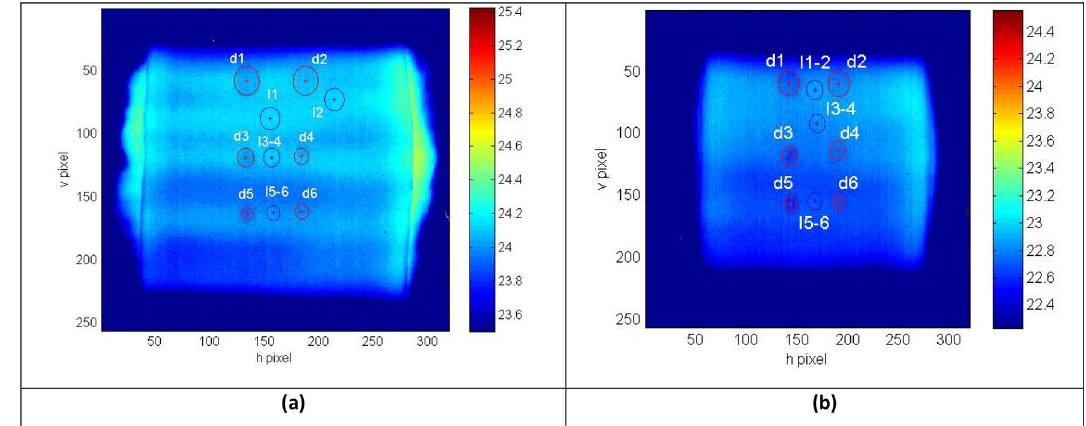
Fig. 14 Thermal processing defect map with SMArt thermography and different heating time: a 120 s; b 240 s